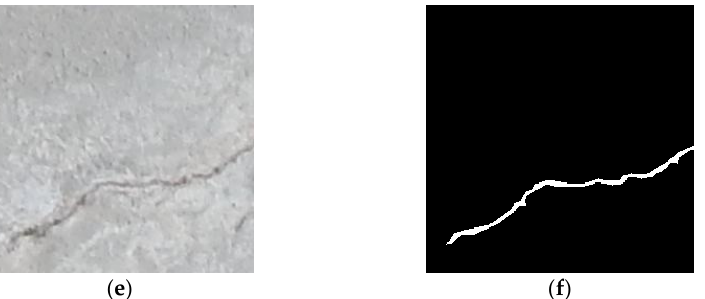
Figure 12. Original and manually labelled images. ( a ) Image I; ( b ) labelled image I; ( c ) image II; ( d ) labelled image II; ( e ) image III; ( f ) labelled image III.